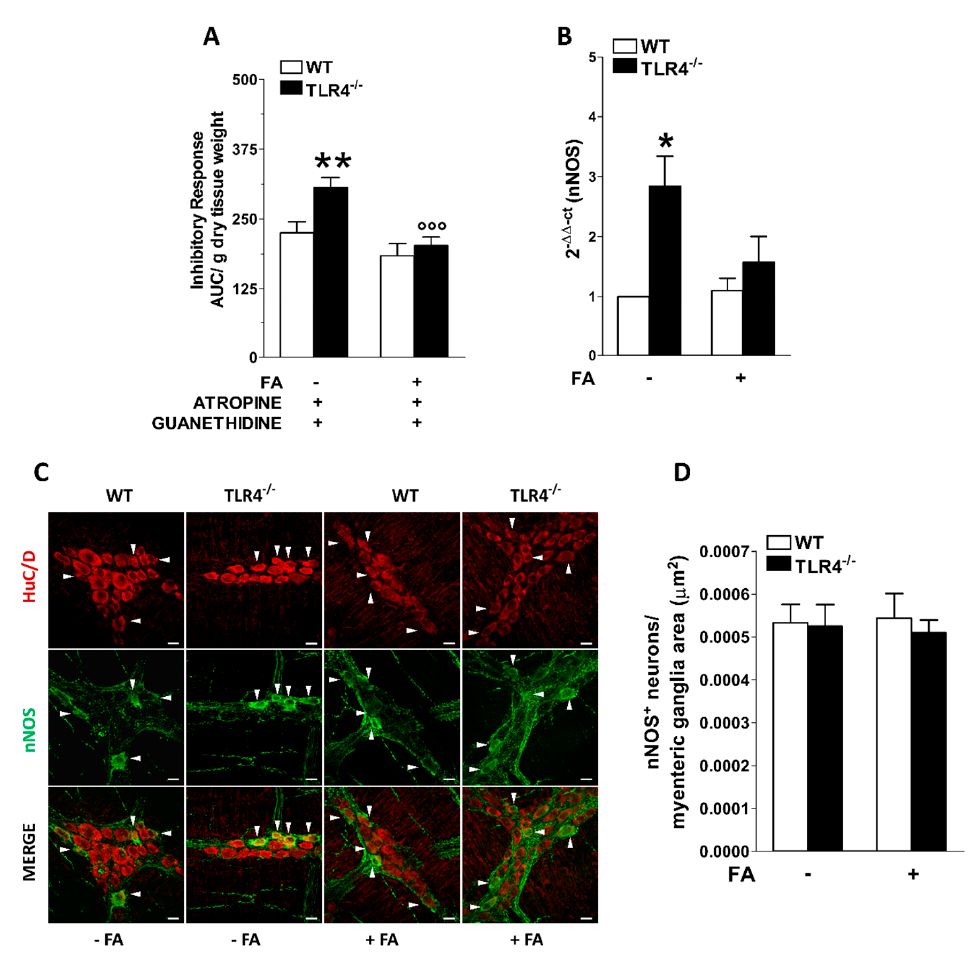
Figure 3. Involvement of EGCs in the modulation of nitrergic neurotransmission of small intestine in TLR4 − / − mice. ( A ) 10 Hz EFS-evoked NANC relaxation responses in ileal segments of WT and TLR4 − / − mice in the presence or absence of 10 µM FA. ( B ) qRT-PCR quantification of nNOS mRNA levels in small intestine segments of WT and TLR4 − / − mice in the presence or absence of 10 µM FA. ( C ) Representative confocal microphotographs showing the distribution of nNOS + (green) and HuC/D + (red) neurons in ileal LMMPs of WT and TLR4 − / − mice in the presence or absence of 10 µM FA (bars = 22 µm). White arrowhead point to HuC/D + nNOS + neurons. ( D ) Number of nNOS + neurons in ileal LMMPs of WT and TLR4 − / − mice in the presence or absence of 10 µM FA. Data are reported as mean ± SEM for all panels. * P < 0.05, ** P < 0.01 vs WT; °°° P < 0.005 vs respective control without FA; N = 6 mice/group.